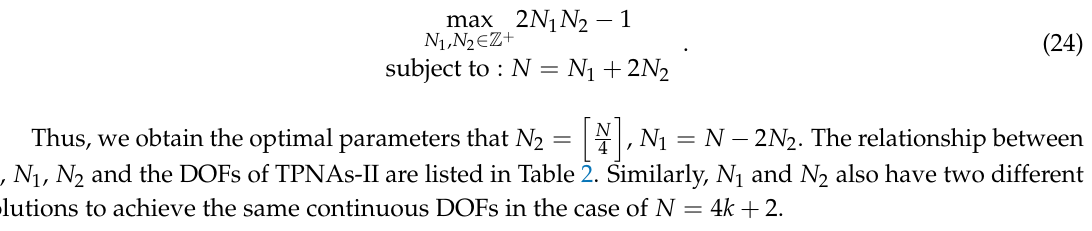
Table 2. The relationship between N , N 1 , N 2 and DOFs of TPNAs-II.